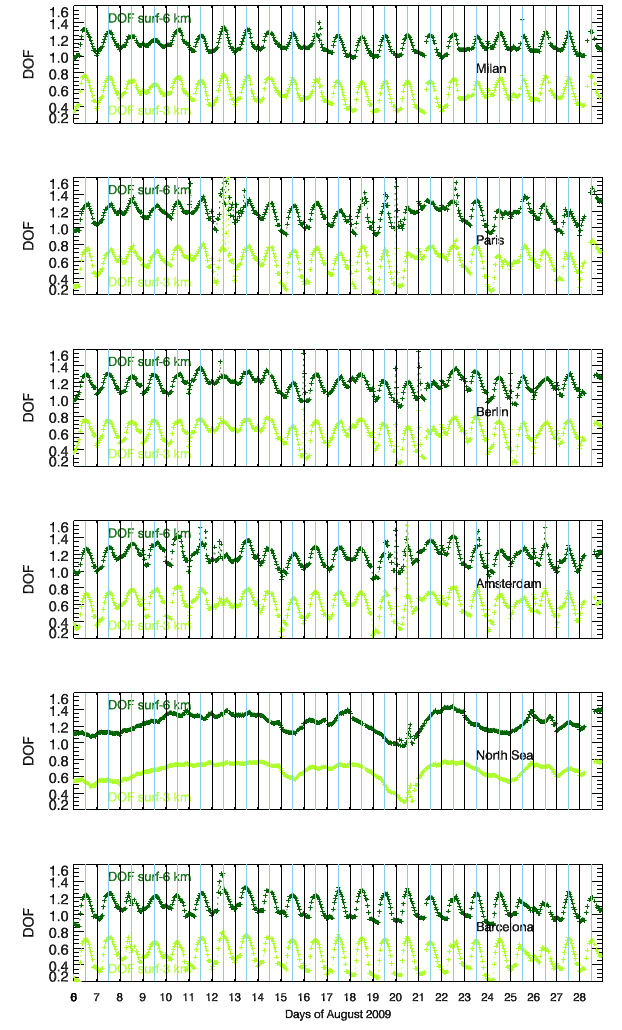
Fig. 8. Time series of the DOFs for surface–6km (dark green) and surface–3km (light green) over Milan, Paris, Berlin, Amsterdam, the marine location west of Norway’s coast, and Barcelona.